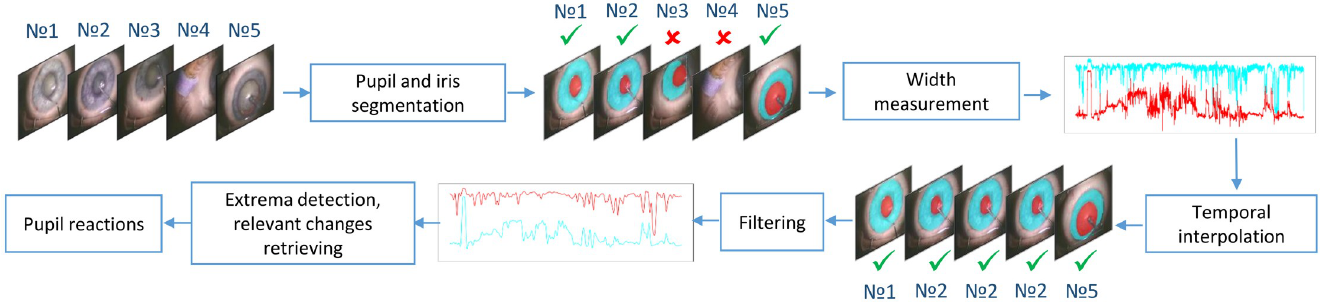
Fig 5. Overview of the proposed pupil reaction detection